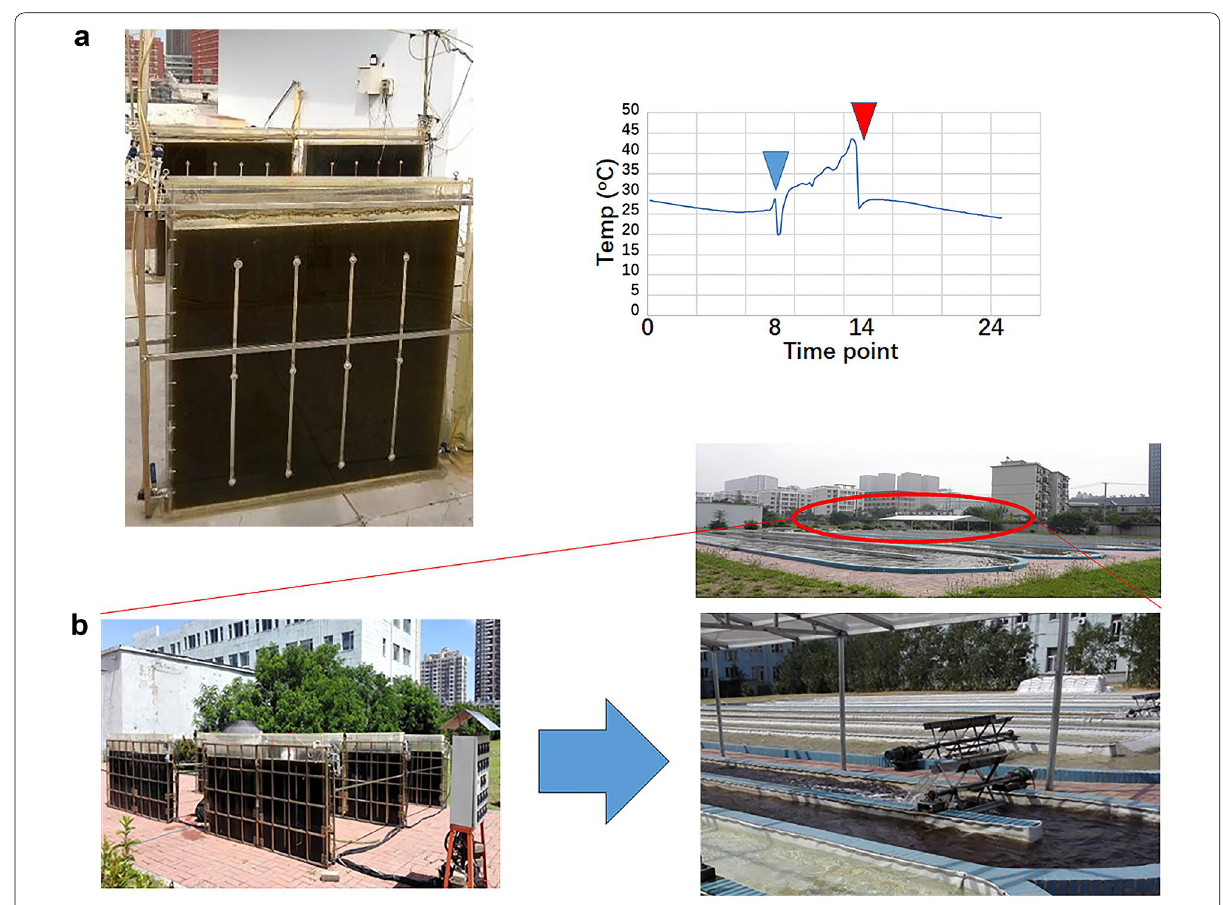
Fig. 1 Pilot-scale cultivation of IM130005 in the summer. a 100 L flat bioreactor and typical temperature variation inside. The first drop of the temperature is caused by the inlet of CO 2 enriched air and the second drop of the temperature is the result of the end of direct irradiation by the sun. b Using 100 L bioreactor for seeding and 1000 m 2 race pond cultivation was achieved by two-stage amplification taken place by Shenyang Research Institute of Chemical Industry Co.,